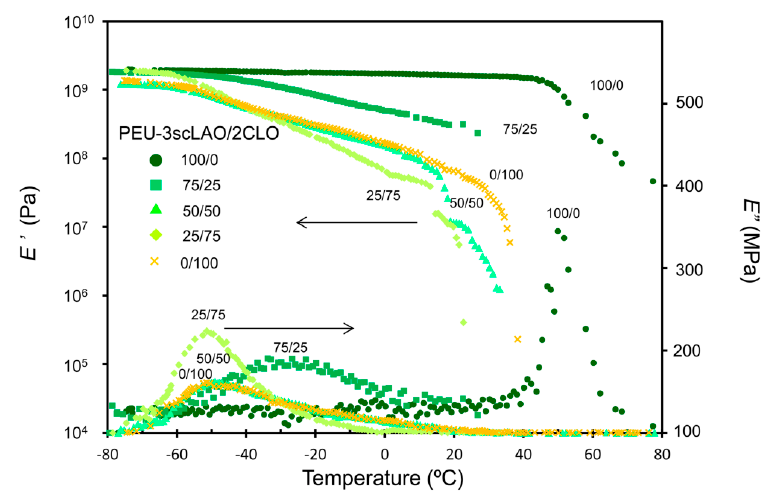
Figure 7. DMA curves of PEU-3scLAO/2CLOs (100/0, 75/25, 50/50, 25/75 and 0/100).